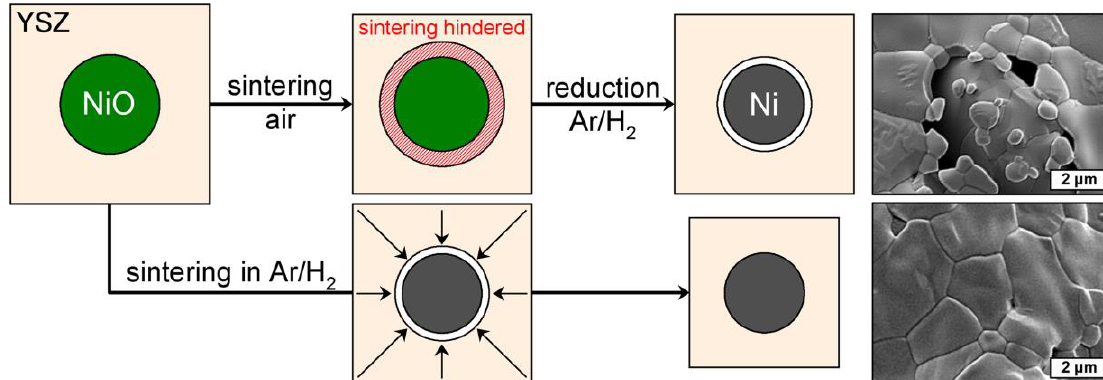
Figure 3. Schematic representation of the sintering of NiO–YSZ composites: Top: Subsequent sintering and reduction-the densification of YSZ is hindered by the NiO, which is less active towards sintering → voids are formed after reduction to Ni; bottom: combined sintering and reduction in Ar/H 2 atmosphere-NiO is reduced to Ni before sintering of YSZ starts → higher shrinkage of the composite, less formation of voids.